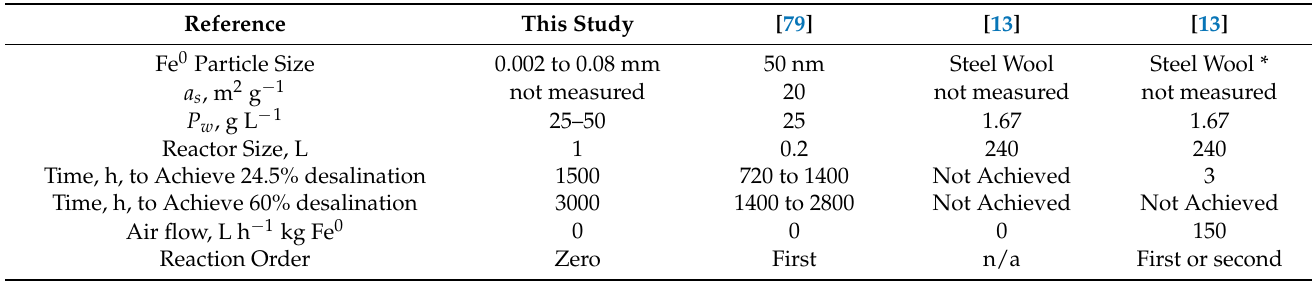
Table 6. Comparison of ZVI desalination pellet performance with the desalination performance of 50 nm Fe 0 (PVP (polyvinylpyrrolidone) coated) and steel wool (Fe 0 :Fe(b)@ureapolymer); a s = particle surface area; P w = ZVI concentration. * = steel wool (Figure 7), which is operated in a catalytic pressure-swing-adsorption-desorption diffusion reactor.